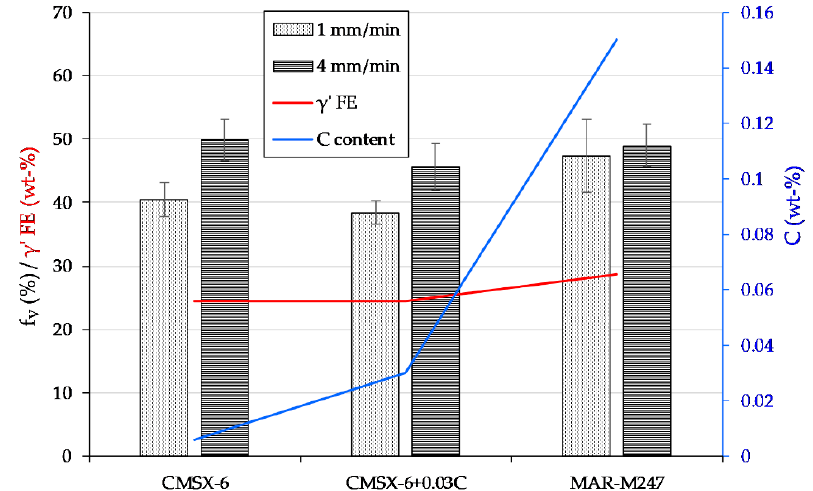
Figure 11. Volume fraction of γ ’ precipitates in the single crystal part of the samples directionally solidified at different rates.